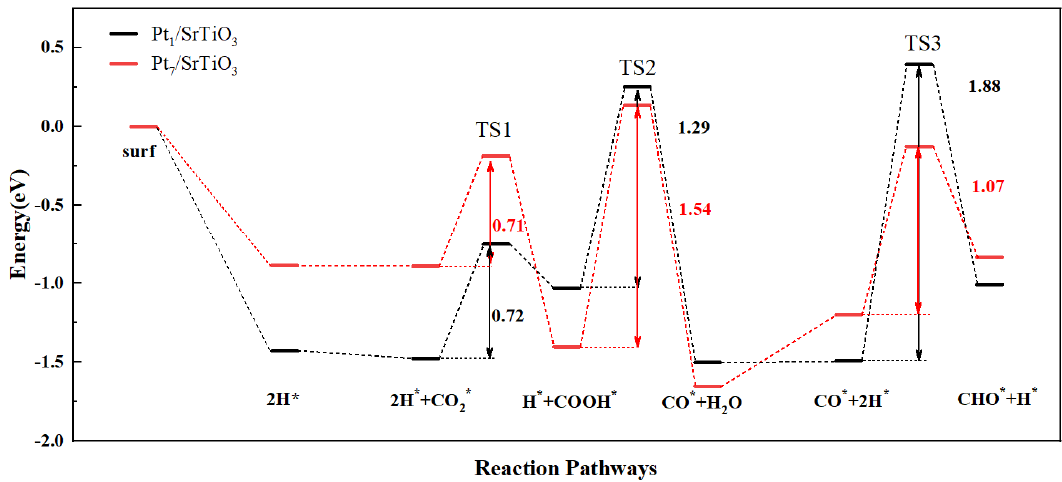
Figure 8. Calculated potential diagram by DFT for the redox mechanism of reverse water-gas shift reaction on Pt